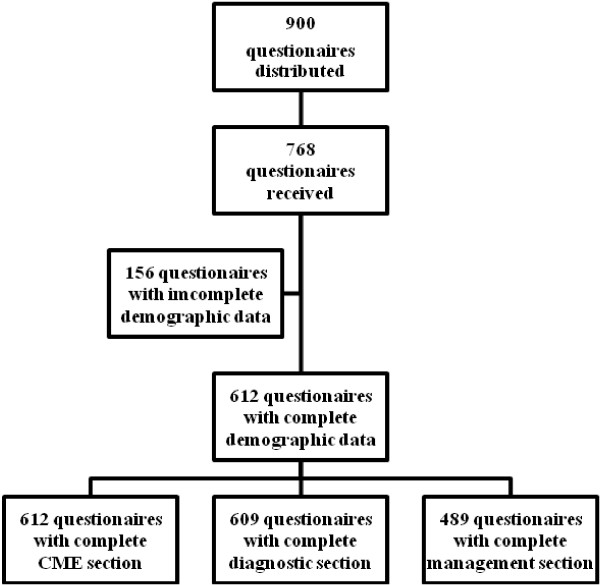
Screening strategy for questionnaires through the survey.